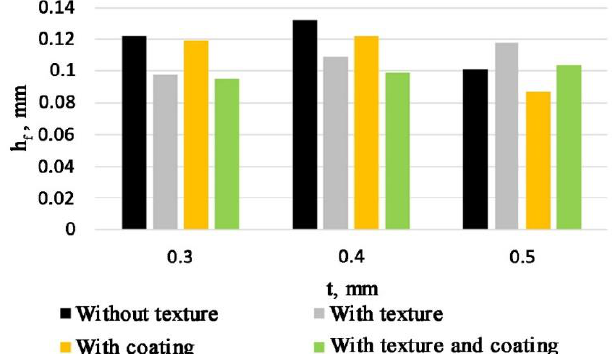
Figure 12. The wear on the flank surface on the different cutting depths dependent on various tools at a cutting speed V = 17 m/min and S = 0.125 mm/rev.